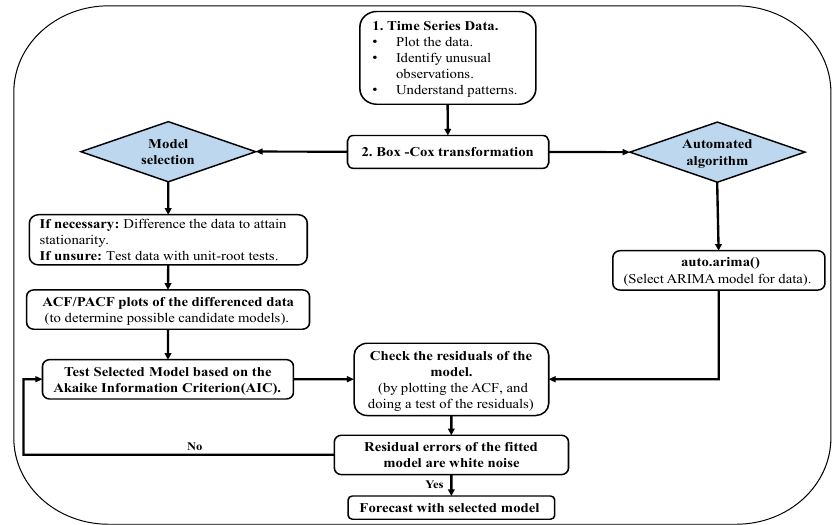
Figure 4. General process for forecasting using an ARIMA model (adapted from [21]).